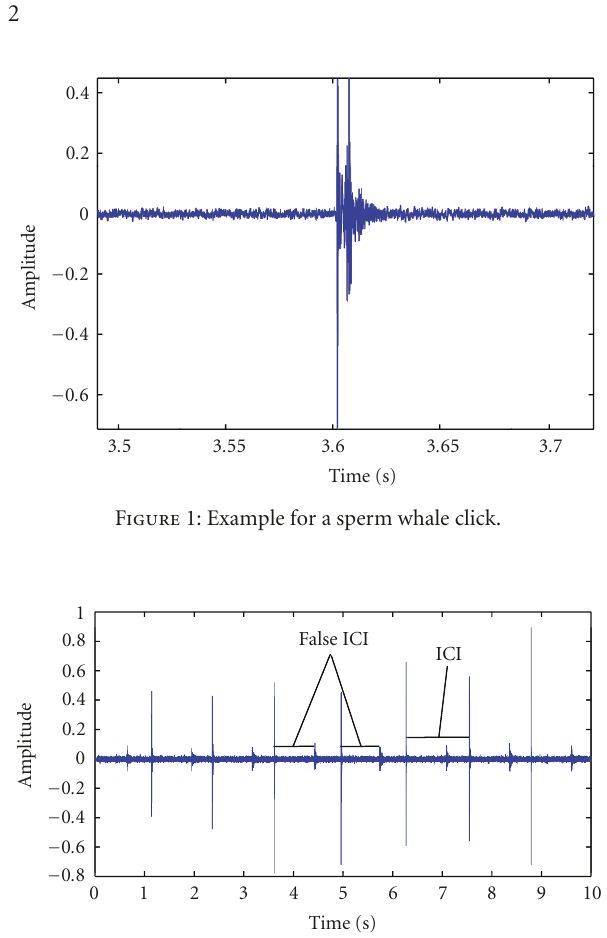
Figure 2: A click train with echoes from a single sperm whale. An ICI and a false ICI are shown.